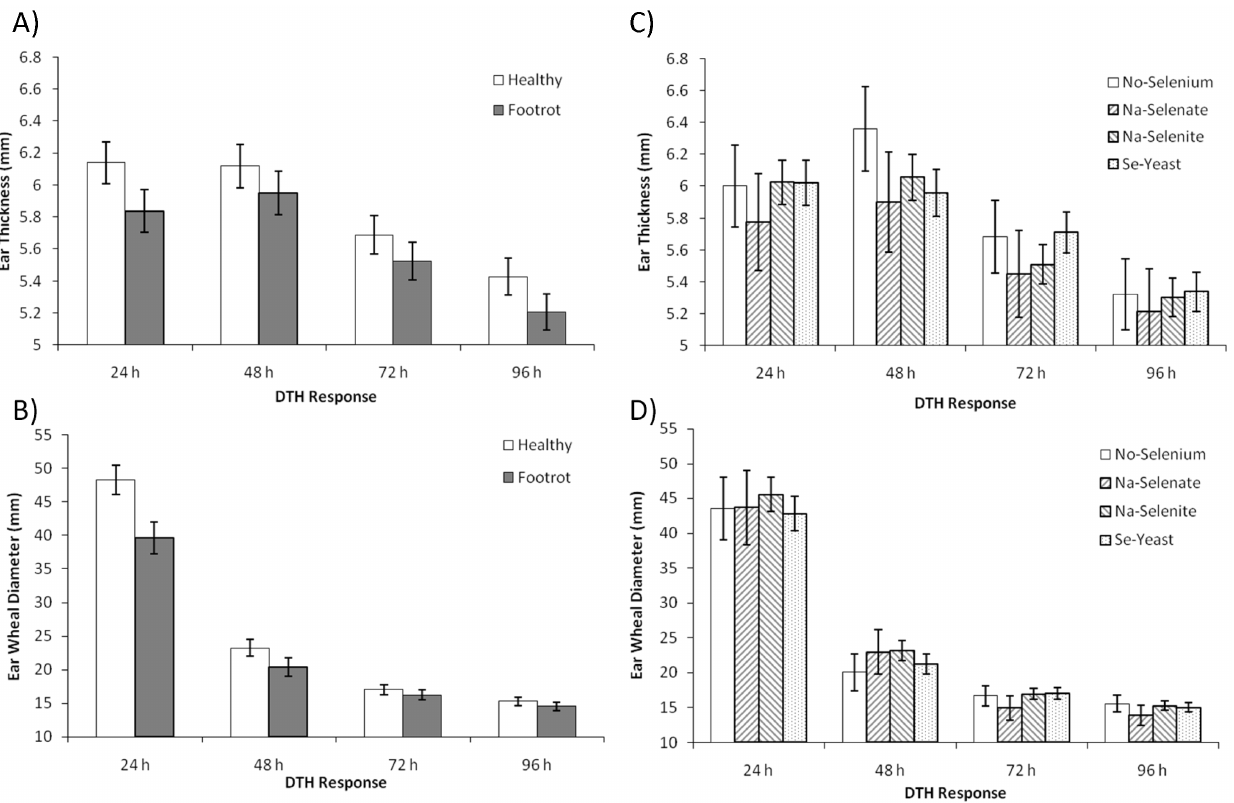
Figure 9. The effect of Se-source and dosage on delayed-type hypersensitivity response to keyhole limpet hemocyanin (KLH). Delayed-type hypersensitivity (DTH) skin test responses was assessed after 52 wk of Se supplementation in healthy and footrot (FR)- affected sheep receiving no Se treatment, Na-selenate at a dosage rate of 8.95 mg Se/wk per ewe, or Na-selenite and Se-Yeast at 4.9, 14.7, or 24.5 mg Se/wk per ewe for 62 wk. (All Se treatment groups were combined.) A ) Ear thickness response was not significantly affected by ewe FR status ( P =0.15). B ) Ear wheal diameter response was decreased in FR-affected sheep (overall P =0.03), which was significant only at 24 h ( P =0.007; P Interaction =0.05). C) Ear thickness response and D) ear wheal diameter response were not significantly affected by Se source or Se dosage.